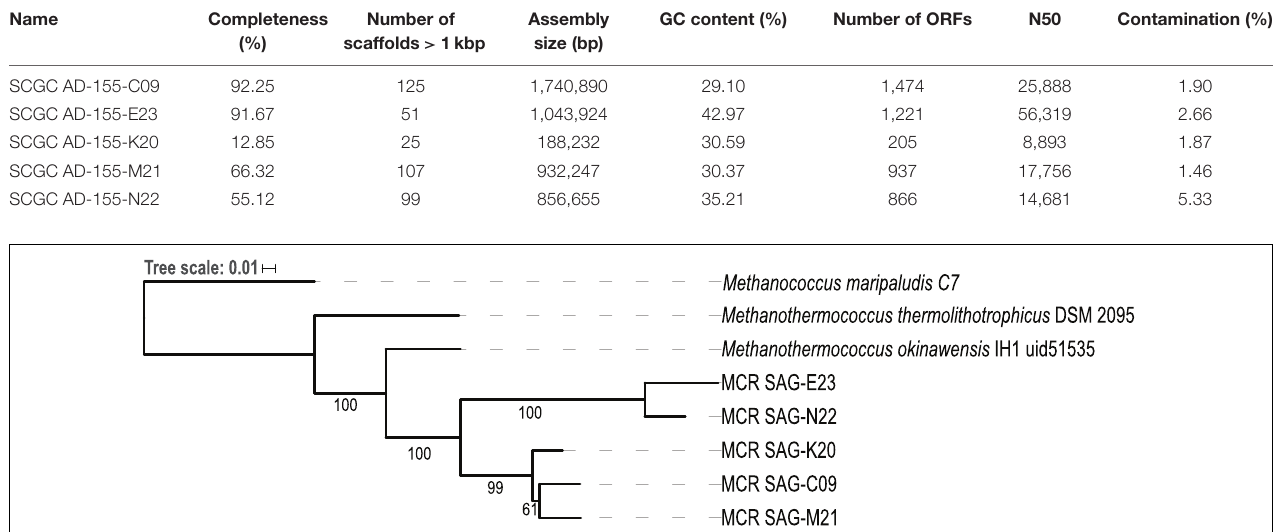
Cracks #2 in the Von Damm vent field. This is roughly consistent with their coverage based on metagenomic mapping ( Figure 2A